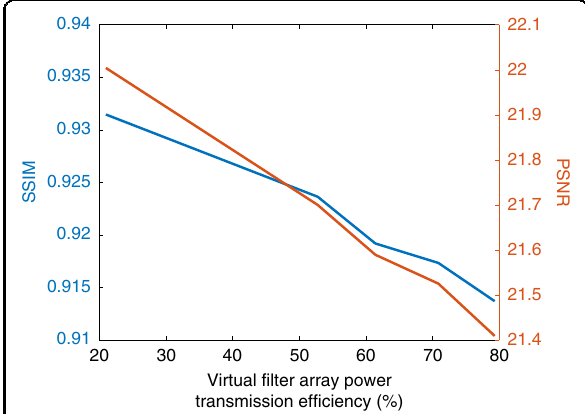
Fig. 9 The trade-off between the multispectral imaging quality and the virtual fi lter array power transmission ef fi ciency. The impact of the additional power ef fi ciency-related penalty term, L e and its weight γ , on the multispectral image cube synthesized by the diffractive multispectral imagers that were trained to form 3 × 3 virtual spectral fi lter arrays assigned to N B ¼ 9 unique spectral bands within the visible spectrum. The optical architectures of these diffractive multispectral imagers are identical to the layout depicted in Fig. 1. We report an average virtual fi lter transmission ef fi ciency of >79% across N B ¼ 9 spectral bands with a minimal penalty on the output image